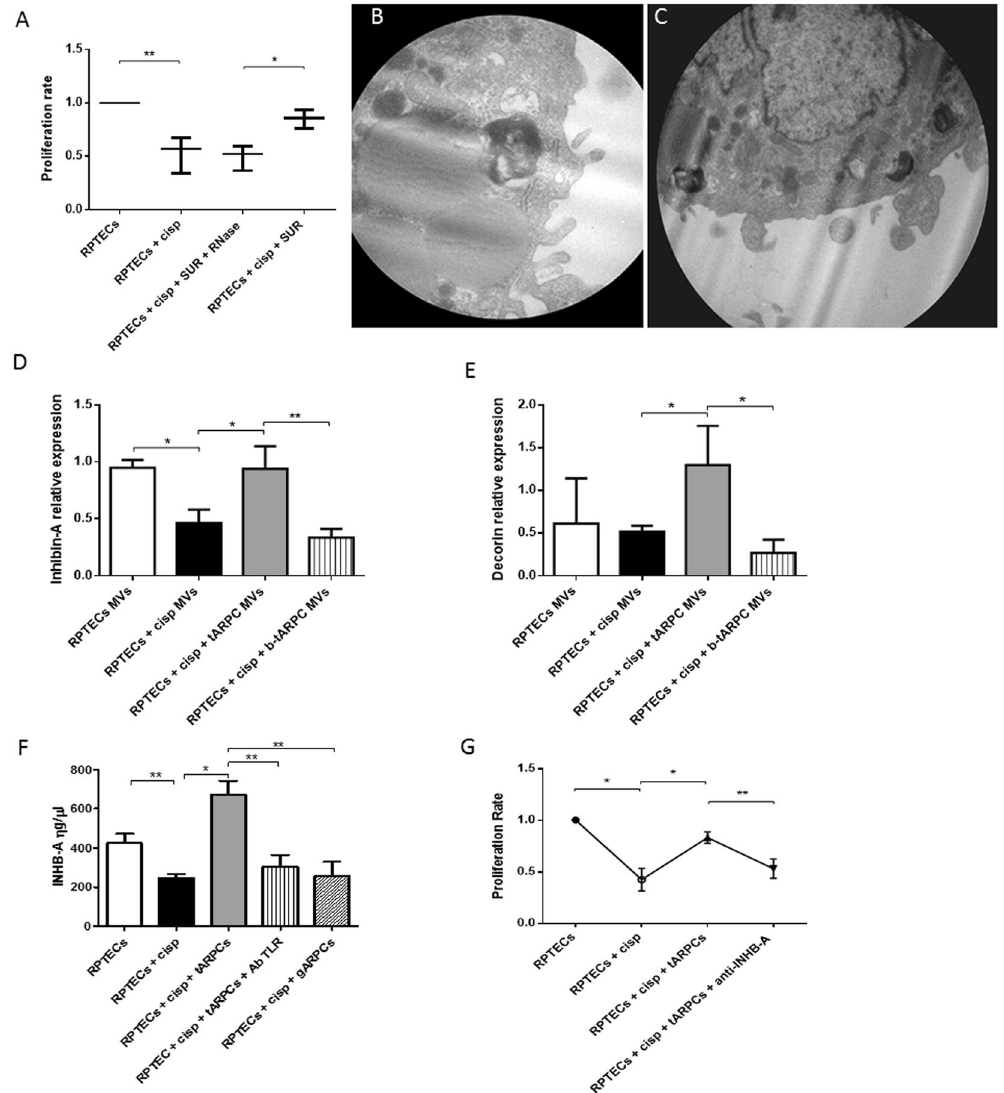
Figure 6. Inhibin-A and decorin were involved in the RPTEC repair. ( A ) Preconditioned supernatants from co-cultures induced an increase of RPTEC proliferation rate. Supernatants treated with 1 U/ml Rnase did not influence the proliferation rate. ( B – C ) Representative micrographs of transmission electron microscopy showing the release of MVs from the surface of a tARPC. Micrographs show the extrusion of MVs from the surface of the tARPC. Ultrathin sections, stained with led citrate were viewed by ZEISS EM910 electron microscope. Image acquisitions were performed with magnification of × 16000. ( D ) MVs isolated from the medium of regenerative condition (cisplatin-damaged RPTECs in co-culture with tARPCs), carried high levels of Inhb-A mRNA, these levels are comparable to the ones found in the supernatant of non-damaged RPTECs. Moreover, Inhb-A levels sharply decreased when TLR2 on tARPCs was blocked. ( E ) MVs isolated from the medium of the regenerative condition (cisplatin-damaged RPTECs in co-culture with tARPCs), carried high levels of Decorin mRNA, these levels were even higher than the ones detected in the supernatant of non- damaged RPTECs. Moreover, Decorin levels sharply decreased when TLR2 on tARPCs was blocked. ( F ) Inhb-A protein level increased in the regenerative condition (cisplatin-damaged RPTECs in co-culture with tARPCs), and this increase was abrogated when TLR2 receptor was blocked reaching levels similar to those obtained in the damaged condition. Inhb-A did not increased in the co-cultures of gARPCs with damaged-RPTECs. ( G ) BrdU cell proliferation assays showed that if we treated the regenerative medium (cisplatin-damaged RPTECs in co-culture with tARPCs) with the Inhb-A blocking antibody the damaged-RPTEC failed to recover their proliferation rate. Plots represent 5 independent experiments using tARPCs from 5 different subjects; * P < 0.05, ** P <